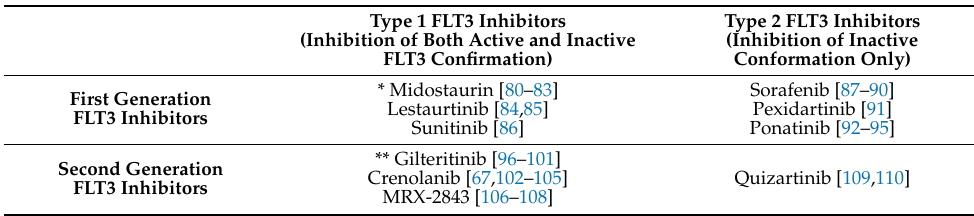
Table 1. FDA-approved and in-development FLT3 inhibitors, displayed by generation (first or second) and tyrosine kinase inhibitor type (type 1 or type